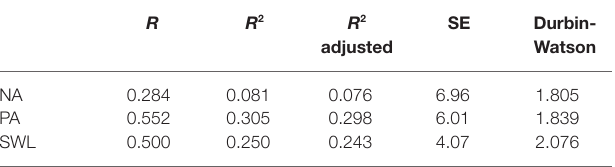
TABLE 2 | Goodness of fit for regression models.